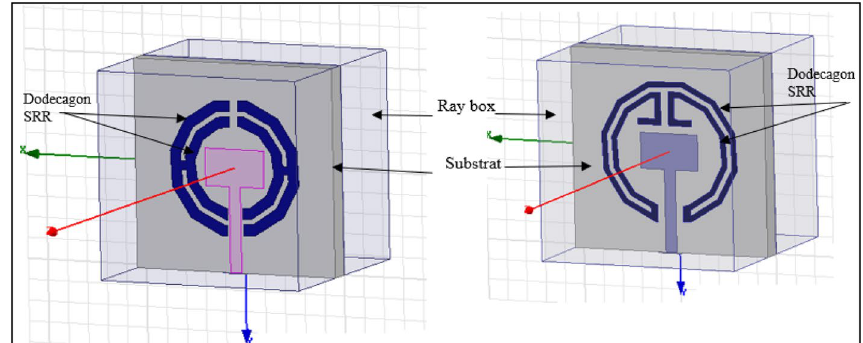
Fig. 5 Proposed shapes of dodecagon resonator in HFSS